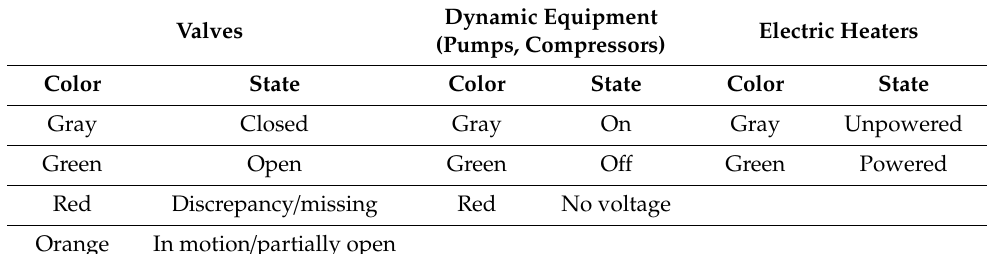
Table 3. Graphic interface color-assignment interpretation.